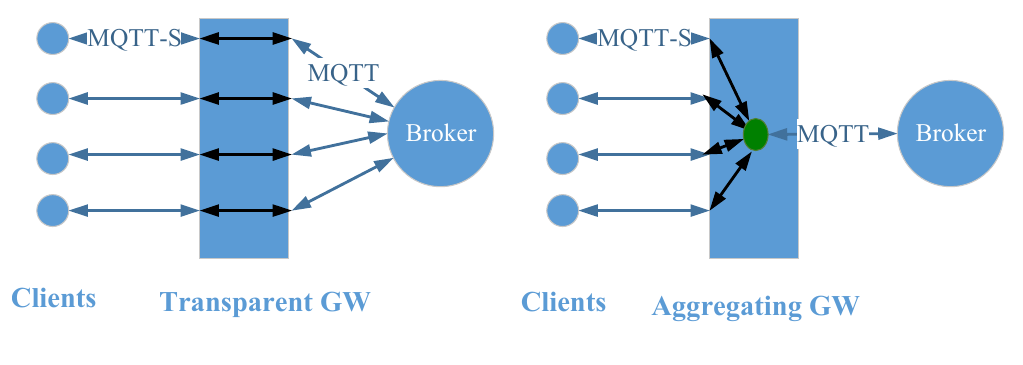
Figure 4. Transparent and Aggregating